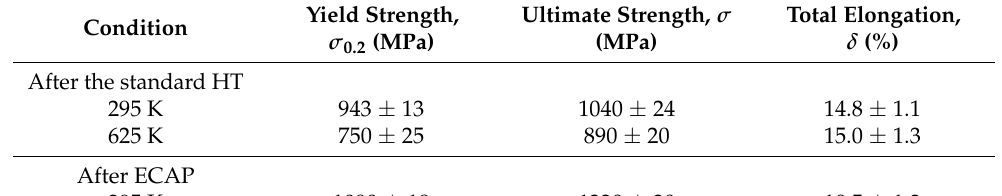
Table 2. Mechanical properties of the Ti-6Al-4V alloy samples at 295 and at 625 K.